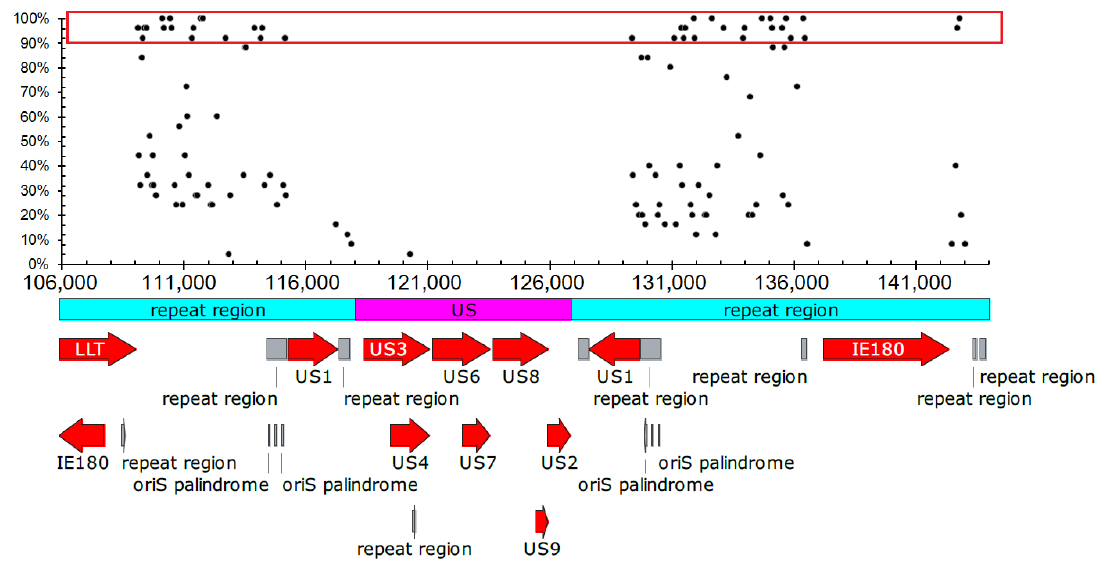
Figure 4. Distribution of G 2 -PQS in repeat regions in PRV genome.